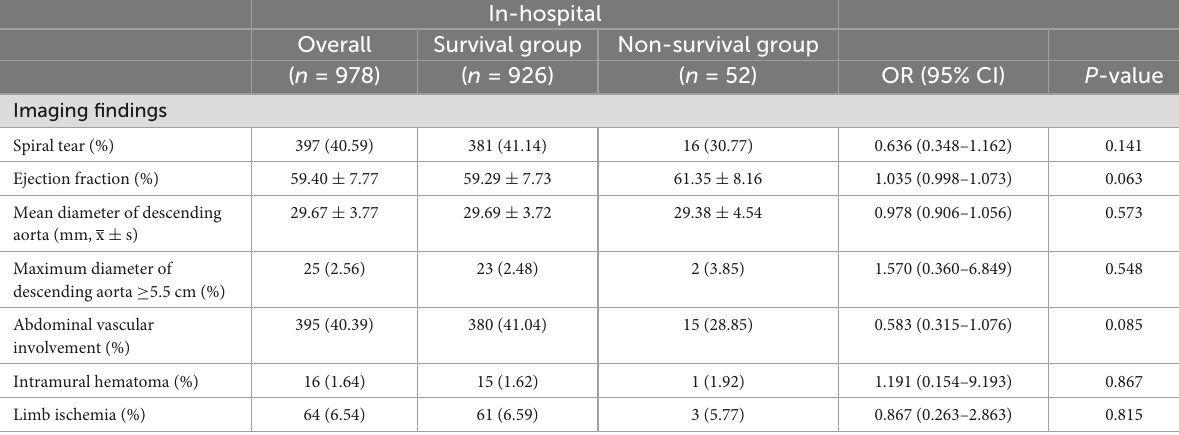
TABLE 3 Diagnostic imaging findings of all patients with Stanford type B aortic